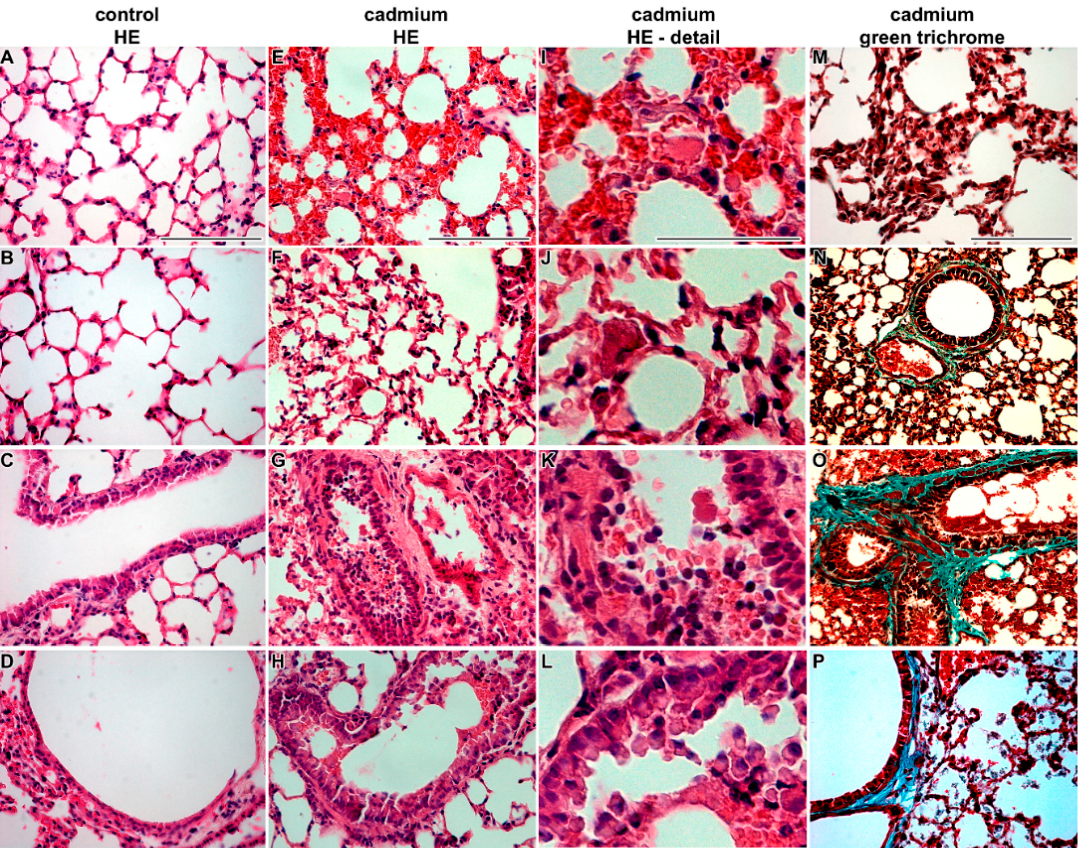
Figure 1. Effect of cadmium nanoparticles on lung tissue following six weeks exposure to CdO nanoparticles: ( A – D ) control tissues; and ( E – P ) cadmium nanoparticles exposed tissues. Hematoxylin-Eosin and Green Trichrome staining. Scale bar: A – H = 100 µm, I – L = 50 µm, M – P = 100 µm.